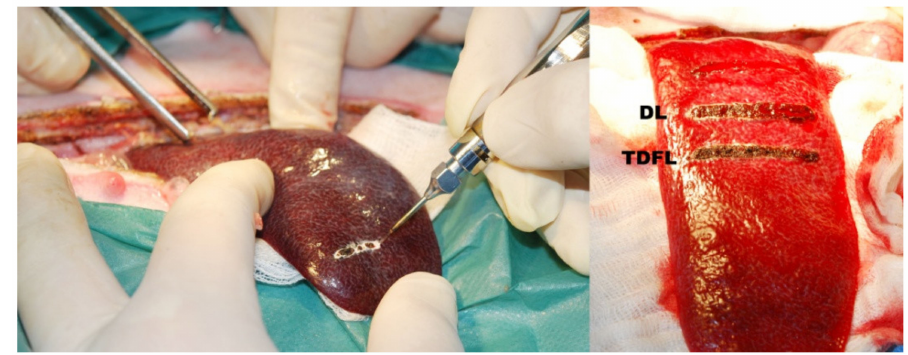
Figure 1. Pictures taken intraoperatively showing (left ) the procedure of spleen incision with a laser probe, and ( right ) two incisions on the spleen made with a diode laser (DL) and thulium-doped fiber laser (TDFL).